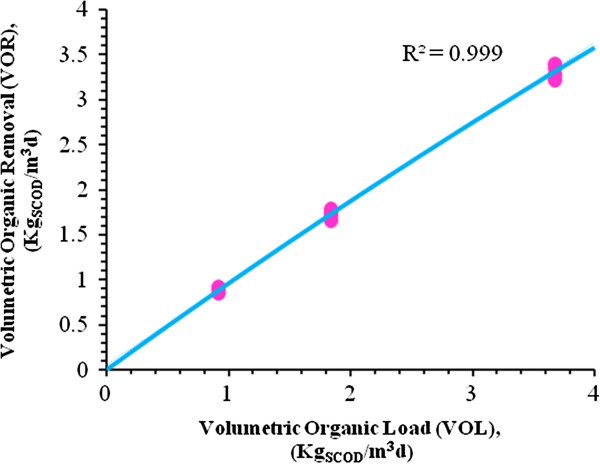
Organic loading of the bioreactor in the range of 0 to 4KgSCOD/m3d at 32°C.